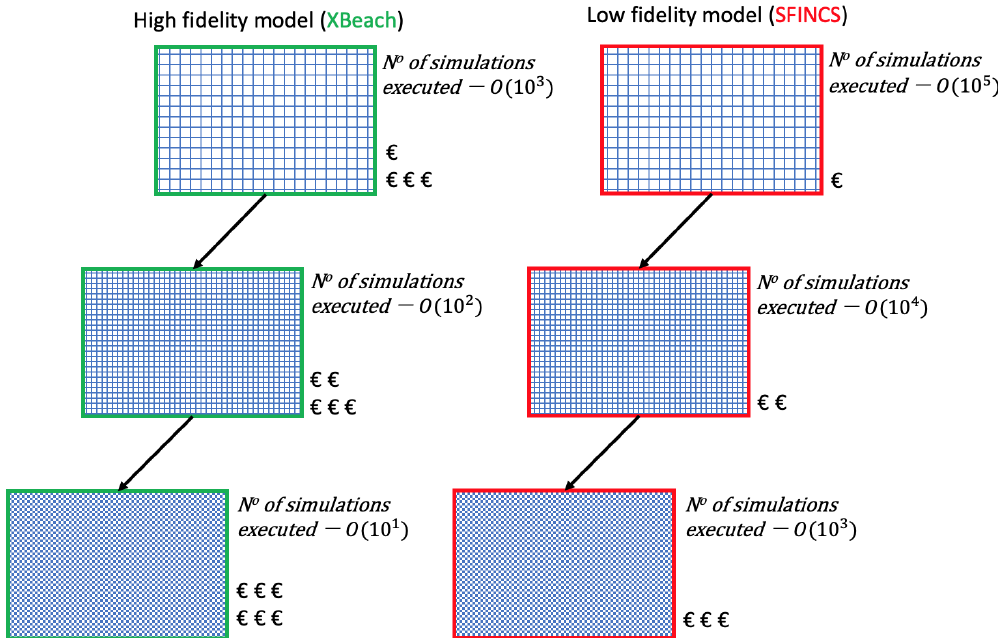
Figure 1. Example illustration of how MLMF’s multifidelity multilevel approach using SFINCS and XBeach models on different grid resolutions results in computational cost savings. Note that the C symbol indicates the order of magnitude of the computational cost for a single simulation with this model at this grid resolution; i.e. CC indicates O( 10 2 ) s for a single simulation. The orders of time and number of scenarios are approximately those for the Myrtle Beach test case in Sect.